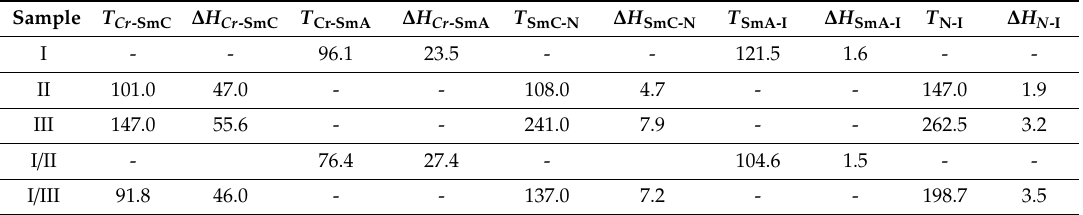
Table 2. Phase transition temperatures ( T , ◦ C) and enthalpy of transition ( ∆ H , kJ / mol) for the individual compounds ( I , II and III ) and their supramolecular complexes ( I / II and I /